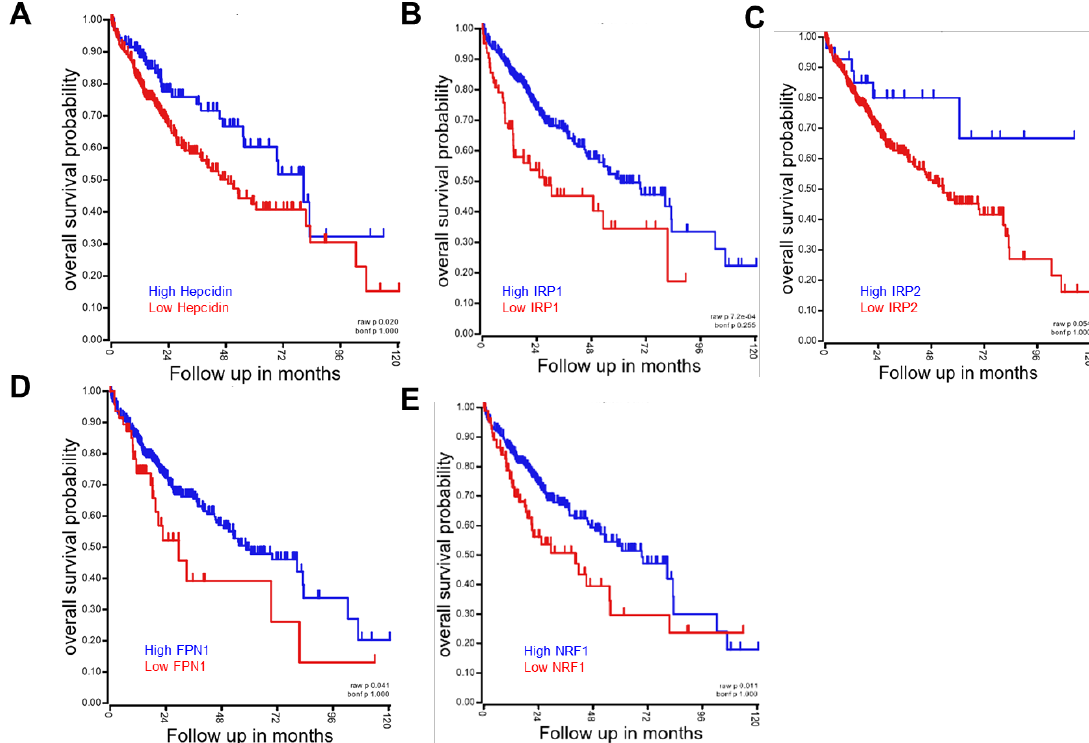
Figure 3. Examples for roles of iron stress sentinels in hepatocellular carcinoma (HCC) survival. The Kaplan–Meier survival plots based on the expression of genes (Hepcidin (cutoff=395.45, (A) ), IRP1 (cutoff = 2167.24, (B) ), IRP2 (cutoff = 1563.70, (C) ), FPN (cutoff = 2757.82, (D) ) and NRF1 (cutoff = 6179.32, (E) ), which were obtained from tissues in the patients with HCC (TCGA-LIHC, n = 371). This was generated by the Cancer Genome Atlas (TCGA) Research Network: http://cancergenome.nih.gov/. NRF2 did not display significant patterns of gene-associated survival in the present dataset.